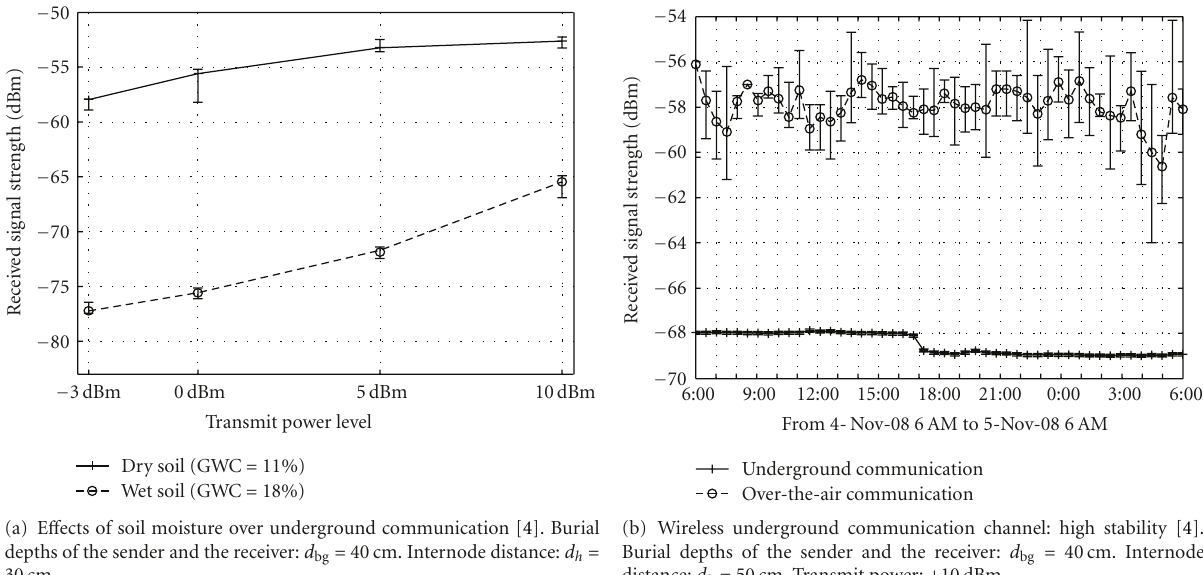
Figure 12: WUSN testbed results (UG2UG) with commodity WSN sensor nodes. RSS for dry and wet soil scenarios. Comparison between underground and over-the-air wireless communication.